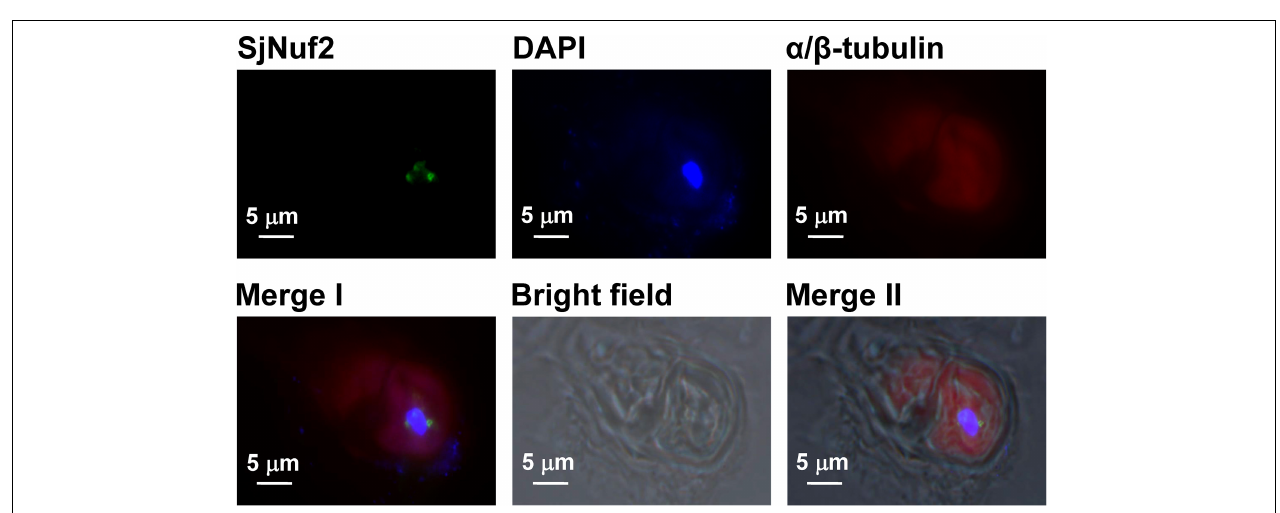
FIGURE 3 | Western blot profiles of the total proteins extracted from Saccharina gametophytes. Lane M, PageRuler Prestained Protein Ladder (Thermo Scientific, Shanghai, China); Lane 1, electrophoresis profiles of the total extracted proteins using radioimmunoprecipitation assay (RIPA) buffer; Lanes 2 and 3, the blotting signals as stained with anti-SjNuf2 and anti- α / β -tubulin antibodies, respectively.